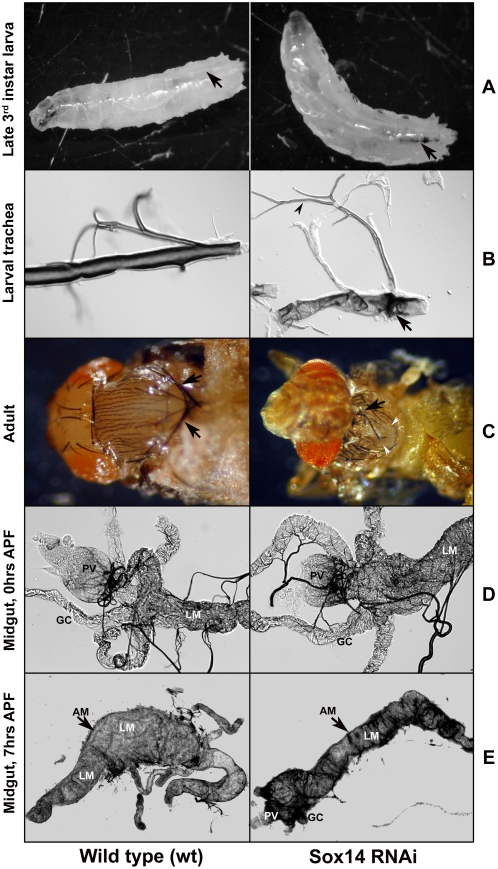

Sox14-RNAi animals have multiple developmental abnormalities including defects in larval midgut destruction.Control wt late 3rd instar larva show normal trachea (left, arrow) but Sox14-RNAi late 3rd instar larva displayed tracheal defects detectable as blackened regions (right, arrow). (B) Dorsal tracheal trunks of Sox14-RNAi animals (right) showed severely distorted taenidial folds, collapse of the tracheal cuticle and blackening of the cuticle (arrow). Branching of the trachea in Sox14-RNAi animals appears to occur normally (arrowhead) as in control wt animals (left). (C) Sox14-RNAi pharate adults dissected from the pupal case showed defects in eyes, notum, and bristles (right, arrow). A control wt pharate adult with normal eyes, notum and bristles (arrows) is shown on the left for comparison. (D) In the 0 hr APF larval midgut (LM) from both control wt (left) and Sox14-RNAi animals (right), the proventriculus (PV) and gastric caecae (GC) are evident. (E) In wt animals, the midgut condensed by 4 hrs APF (not shown) and the gastric caecae were not detectable by 7 hrs APF. Condensed wild type larval midgut (LM) was found within the adult midgut by 7–12 hrs APF (left). Sox14-RNAi animals showed some condensation of the midgut but the proventriculus (PV) and remnants of gastric caecae (GC) can still be observed even after 7–12 hrs APF (right). In both wt and Sox14-RNAi animals, a layer of adult midgut (AM, arrow) can be observed after 4 hrs APF.